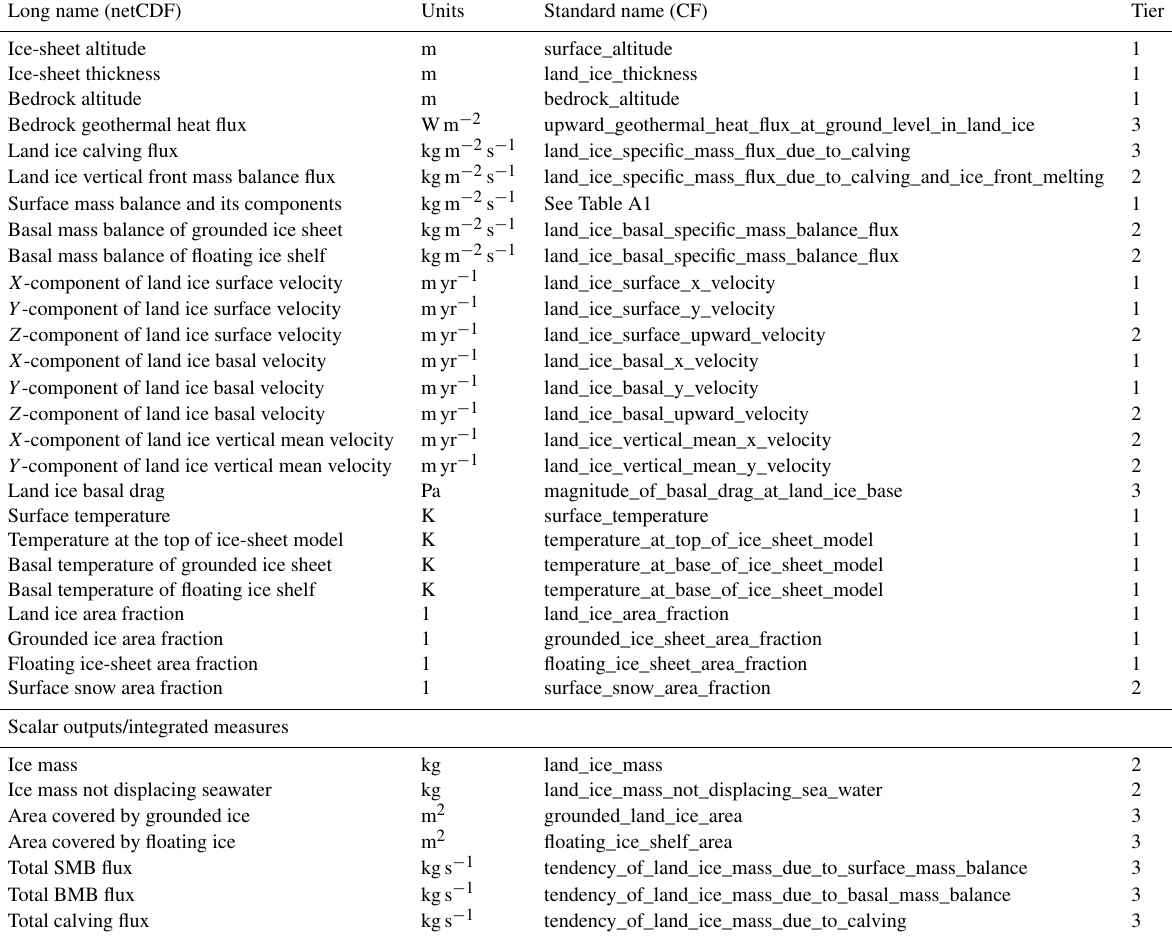
Table A3. Data on the limonAnt, limonGre, liyrAnt or liyrGre tables needed to capture the dynamical ice-sheet model realm. These fields are saved on the ice-sheet grid and contain monthly or yearly output. Tier indicates the priority of the variable: Mandatory (1), Desirable (2), Experimental (3). These variables are requested for models participating in the XXX-withism , ism-XXX-self and ism-XXX-std experiments (Table 2). Flux variables are defined as positive when the process adds mass or energy to the ice sheet and as negative otherwise. Long name